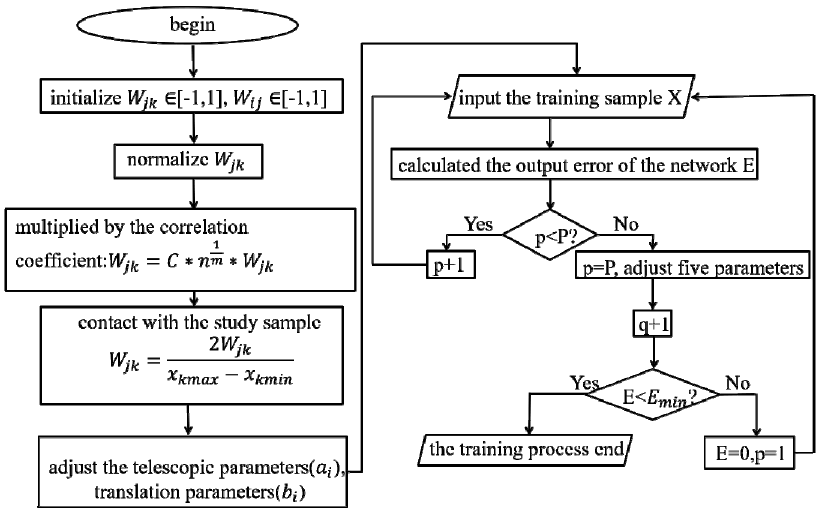
Figure 9. Flow chart for the training process of the wavelet neural network.